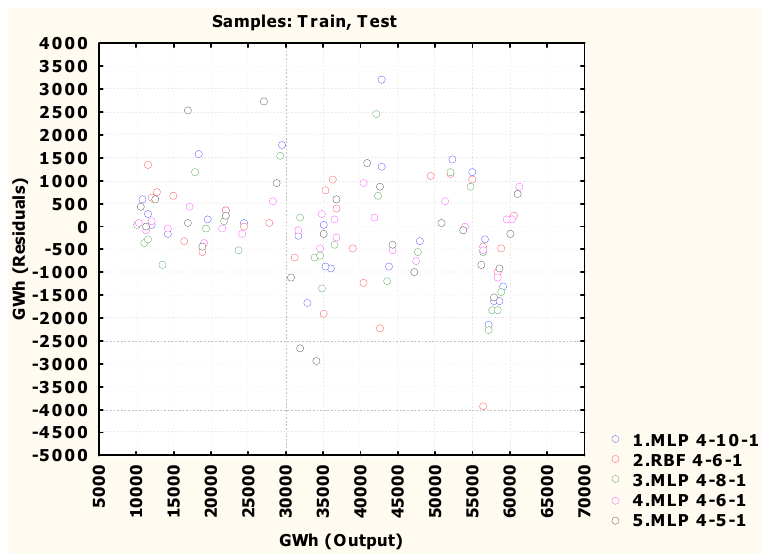
Figure 6. Residuals vs . fitted